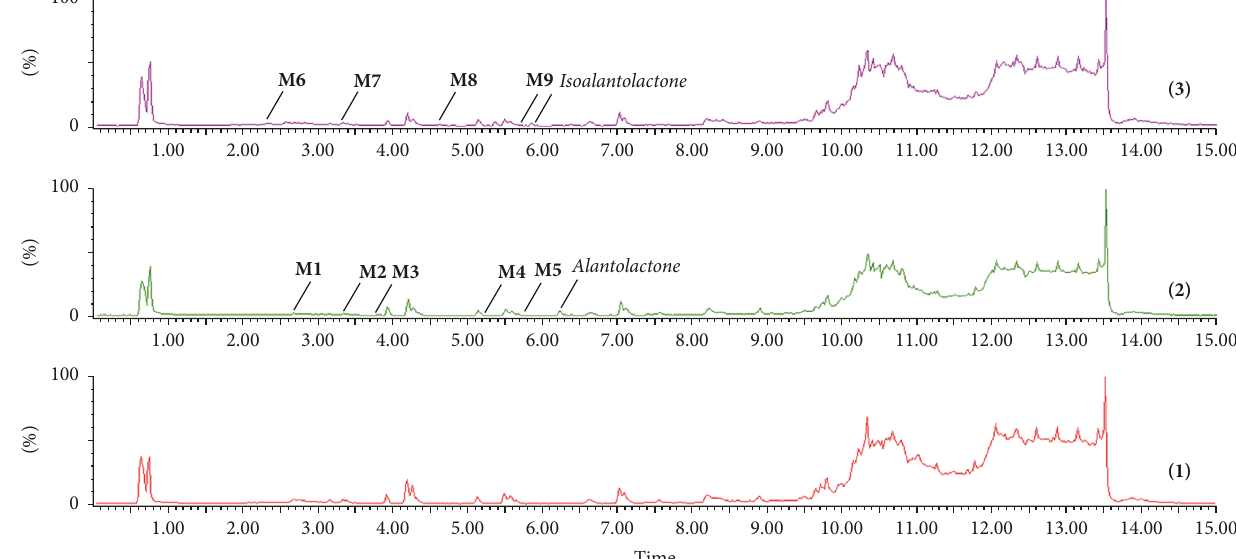
Figure 3: The representative TIC chromatograms of alantolactone and isoalantolactone incubated with rat liver microsomes for 1 h. (1) Blank; (2) alantolactone; and (3) isoalantolactone; M1–M9,